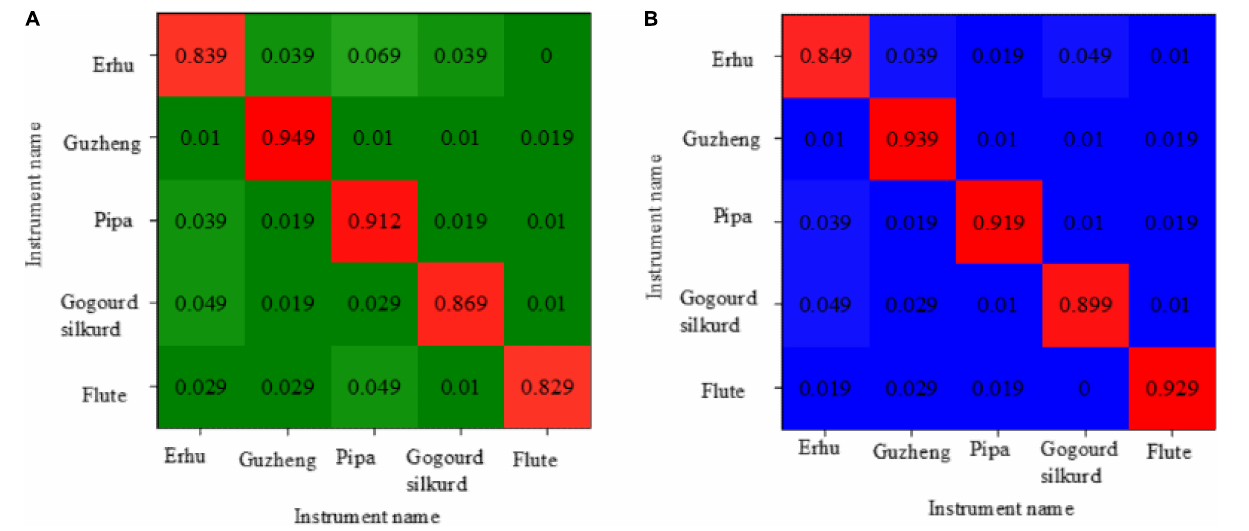
with a total of 3,350 instrument samples. The first step is to mark all instrument samples and then use the training model to cross-check the verification set and predict the instrument samples for the test set. Finally, the actual instrument tag is compared with the predicted instrument tag to obtain the average recognition rate. The DBN-based discrimination algorithm, the KNN discrimination algorithm (Abu Alfeilat et al., 2019), a traditional decision tree discriminator, the softmax function, and support vector machine (SVM) are used to train, test, and detect five national musical instruments, respectively. Figure 9 depicts the average accuracy of recognition and discrimination.